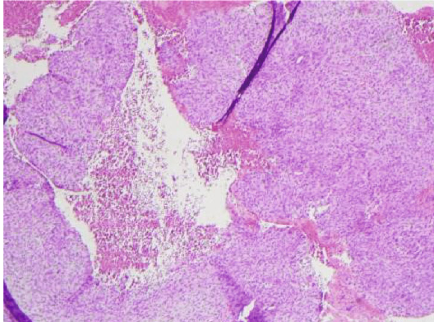
Figure 2: Cyst space in subperiosteal ABC with no lining cells and surrounded by bland fi broblasts and osteoclast type giant cells (H&E, 4x).